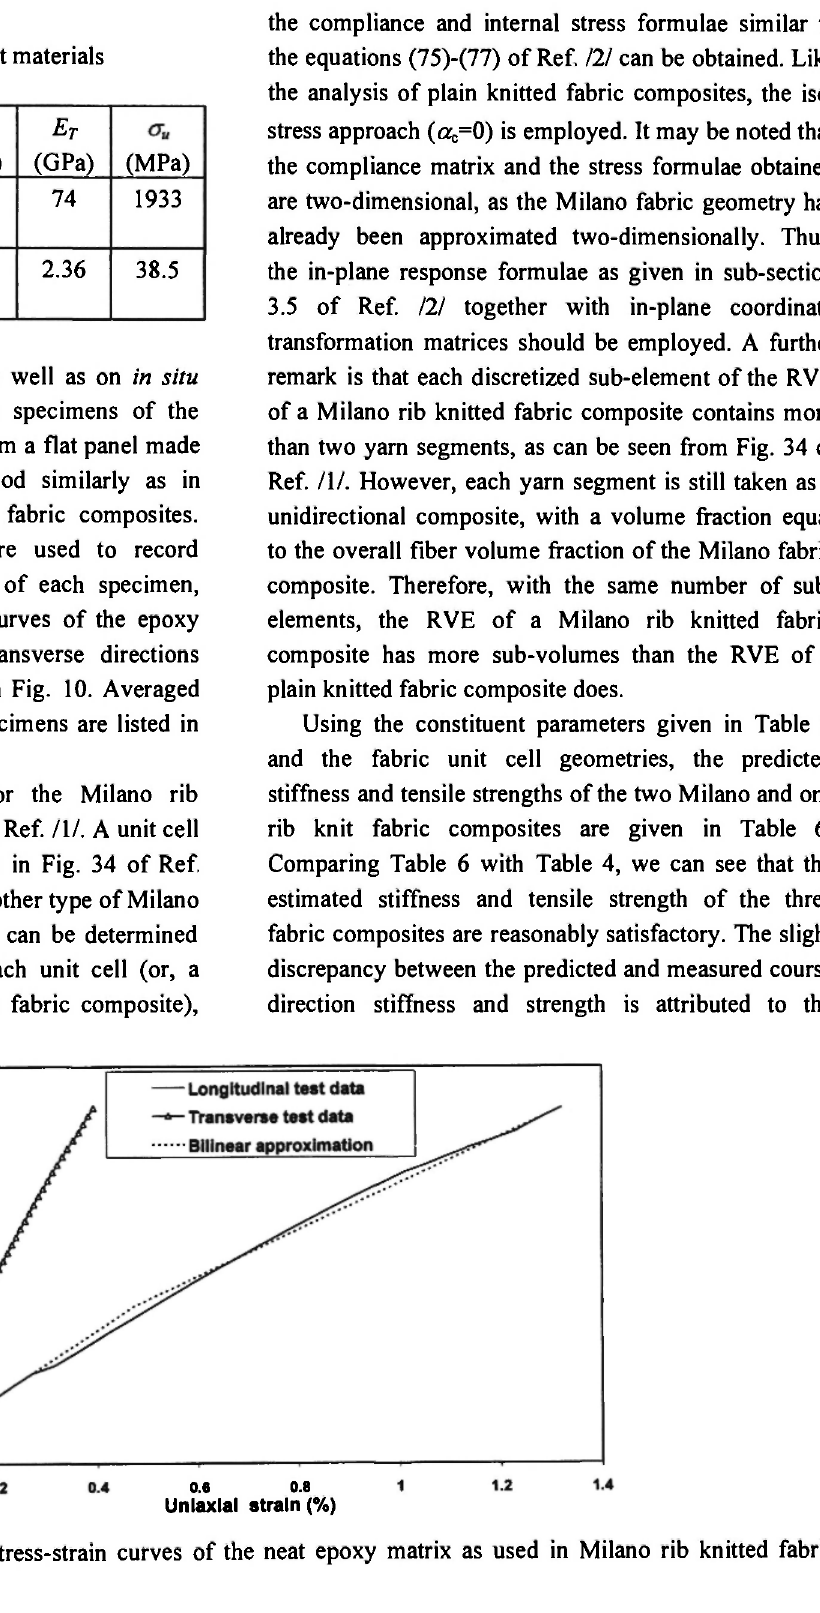
Fig. 10: Typical uniaxial tensile stress-strain curves of the neat epoxy matrix as used in Milano rib knitted fabric